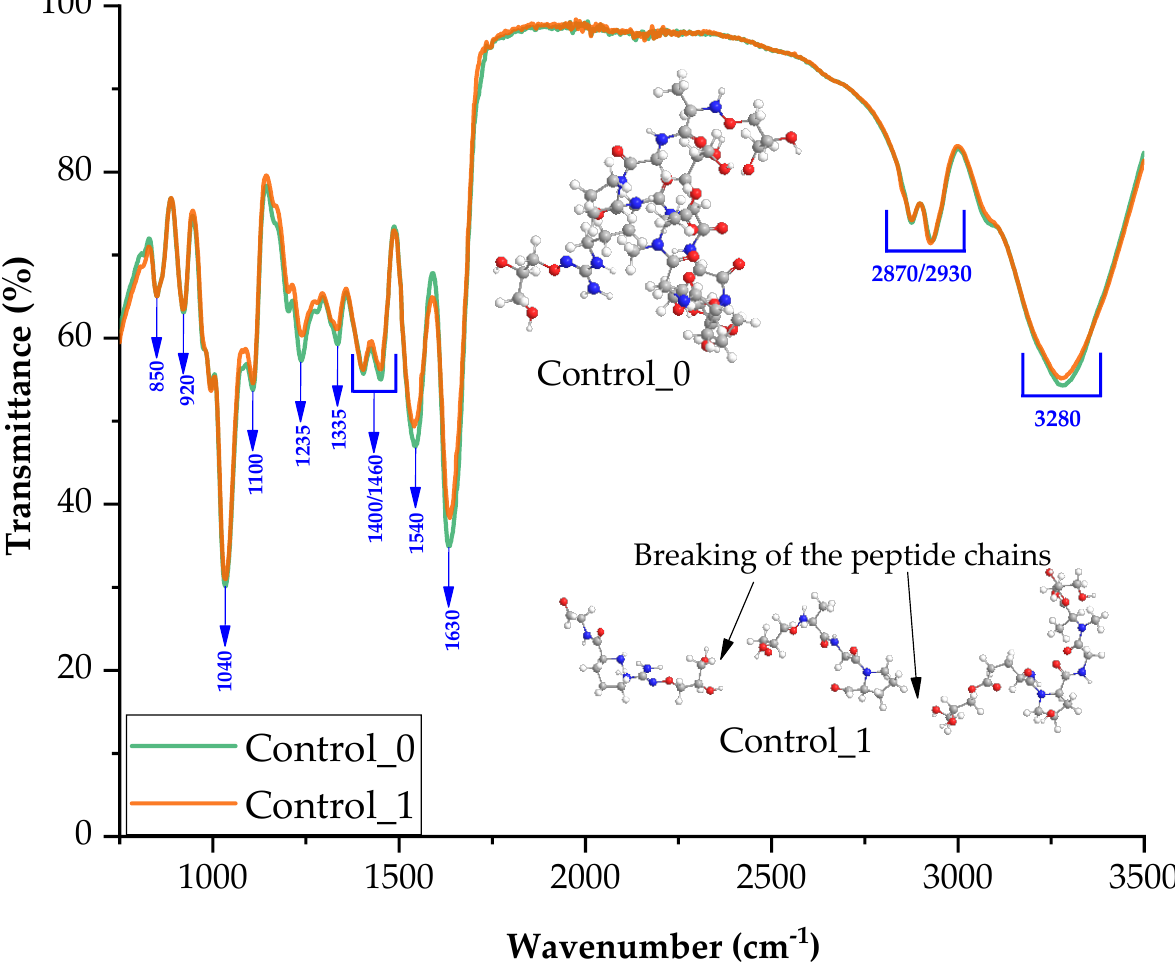
Figure 2. FTIR spectra of samples: Control_0 and Control_1.